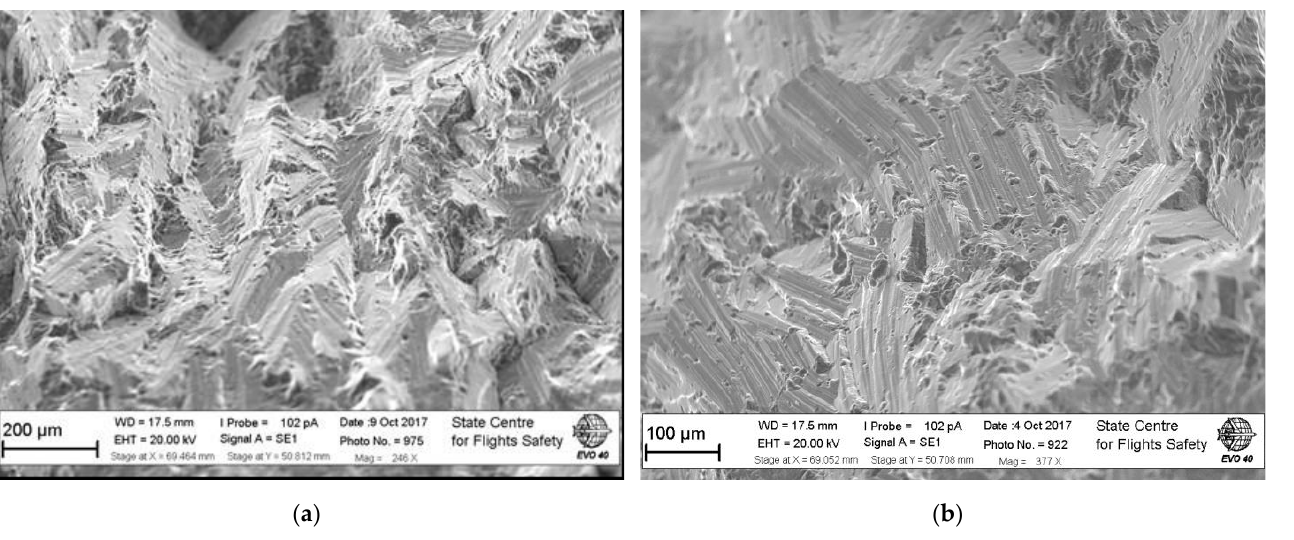
Figure 11. The details of crack growth in hot-rolled specimens VHCF loading. The details of crack growth in hot-rolled specimens with ( a ) surface and ( b ) subsurface VHCF loading. The neighboring packages do not show and priceable features, such as quasi-ductile zones, in translon from one fractured element to another. The borders are mainly sharp independently of mutual orientation. The quasi-brittle fracture surfaces are rarely covered by individual dimples that are probably related to reinforced phases of aluminum alloy.